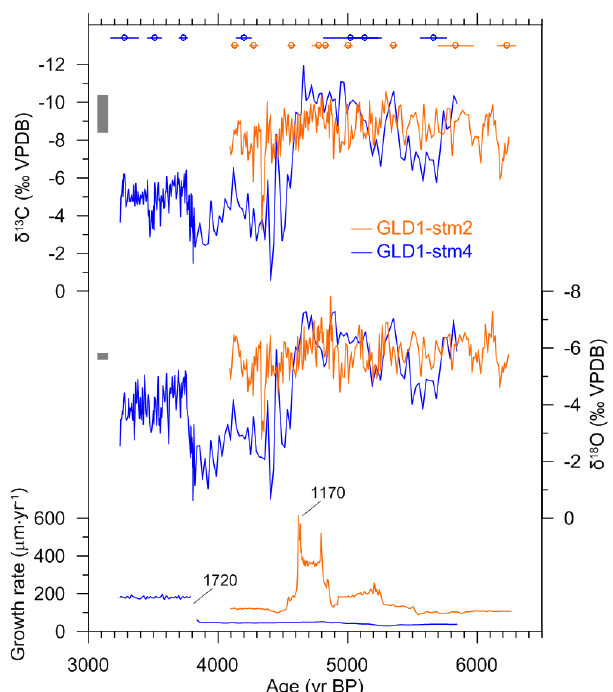
Figure 4. The δ 18 O, δ 13 C and growth rate of stalagmites GLD1- stm2 and GLD1-stm4 from the Gueldaman GLD1 Cave. U/Th dates with 2 σ errors are presented at the top. The isotopic ranges of mod- ern calcites are also shown on the left (rectangles). Growth rates are calculated from the StalAge age model. Note that the extraordi- narily high growth at ca. 4600yrBP in stalagmite GLD1-stm2 and ca. 3800yrBP in stalagmite GLD1-stm4 are likely attributed to ar- tificial simulations by the StalAge program and thus are not fully discussed in terms of climate in the